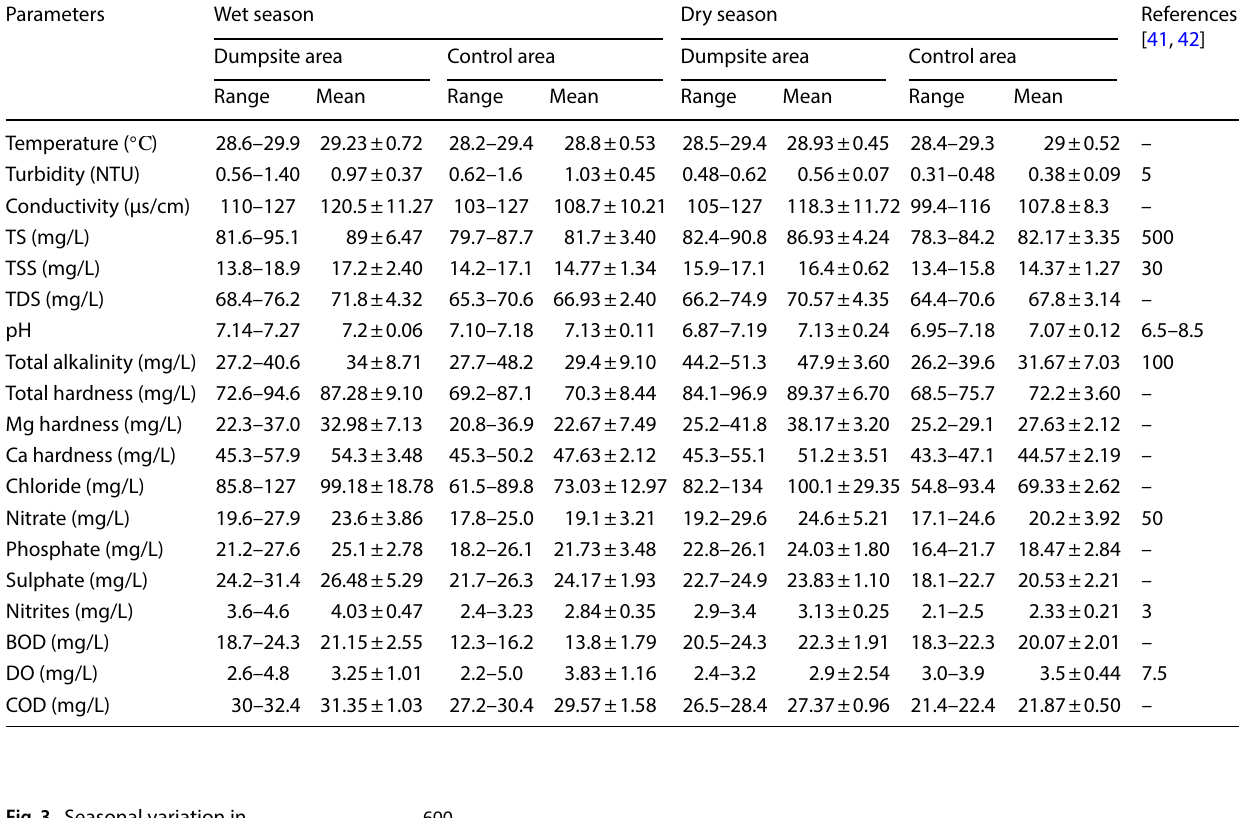
Fig. 3 Seasonal variation in the mean physicochemical parametersfor both study